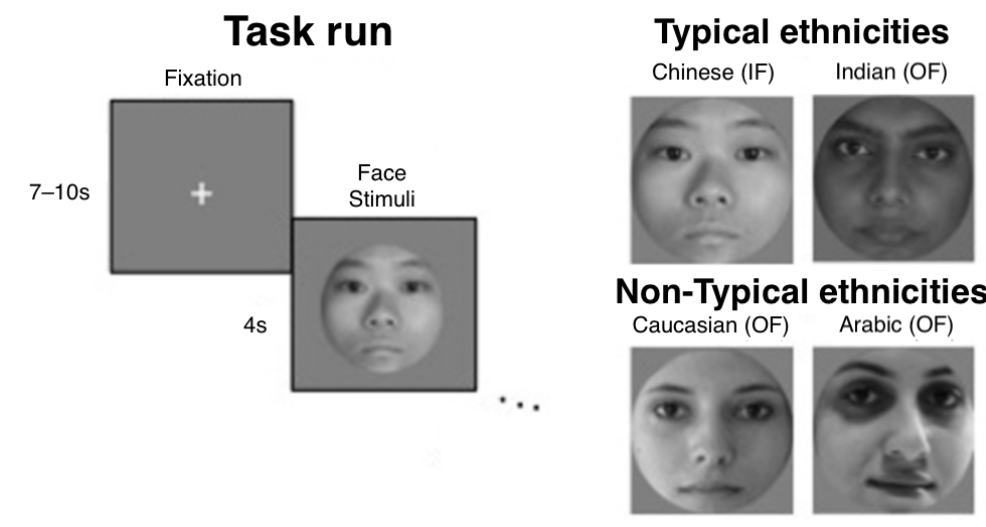
Figure 1. Experimental design in terms of task run (on the left ) and presented stimuli (on the right